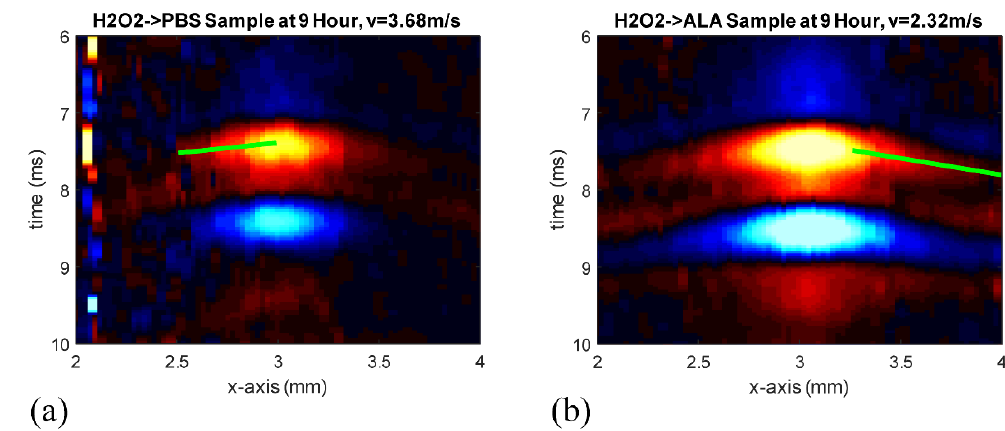
Figure 4. Space-time maps of one ( a ) H 2 O 2 → PBS and ( b ) H 2 O 2 → ALA lens at nine hours. The elastic wave propagation velocity was ( a ) 3.68 m/s and ( b ) 2.32 m/s.